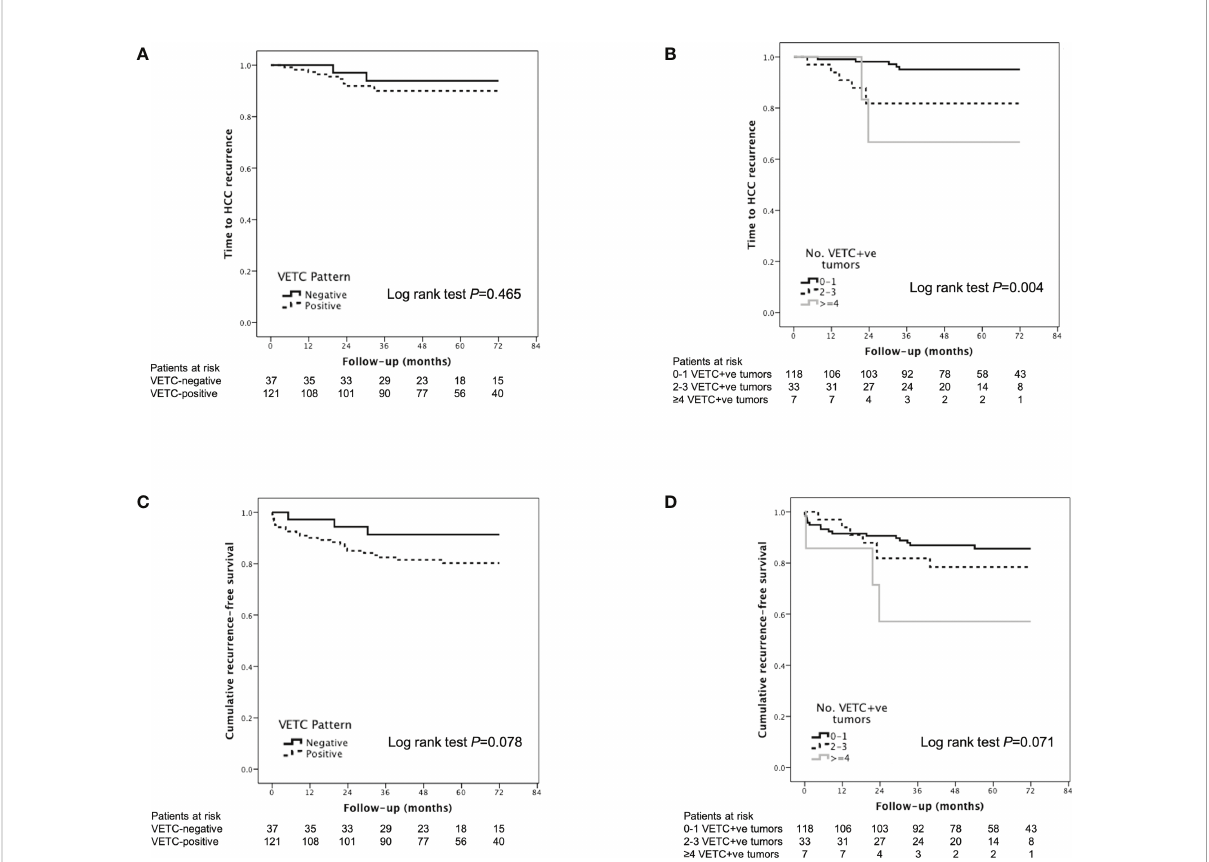
FIGURE 4 Kaplan-Meier analysis of time to recurrence according to (A) VETC-positive vs. VETC-negative patients and (B) number of VETC-positive tumors; and Kaplan-Meier analysis of recurrence-free survival according to (C) VETC-positive vs. VETC-negative patients and (D) number of VETC-positive tumors in patients with HCC receiving LT. HCC, hepatocellular carcinoma; VETC, vessels that encapsulate tumor